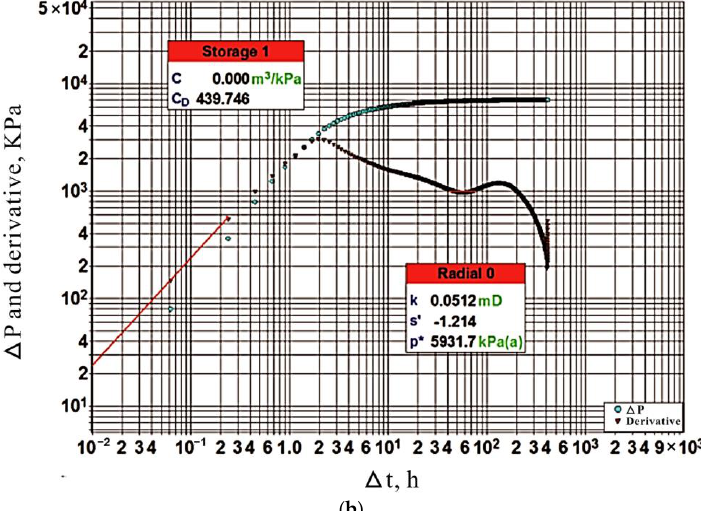
Figure 6. Log-log plot of the pressure difference and derivative of bottom-hole pressure. ( a ) A fracture intersecting the wellbore; ( b ) A fracture near the wellbore.